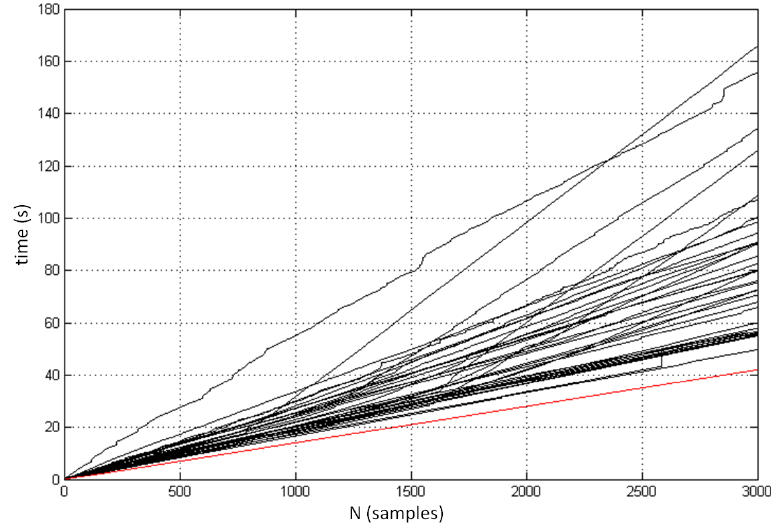
Figure 8. The progress of the measurements in the static scenario (the total time required to collect the initial 3,000 samples at different points in space).